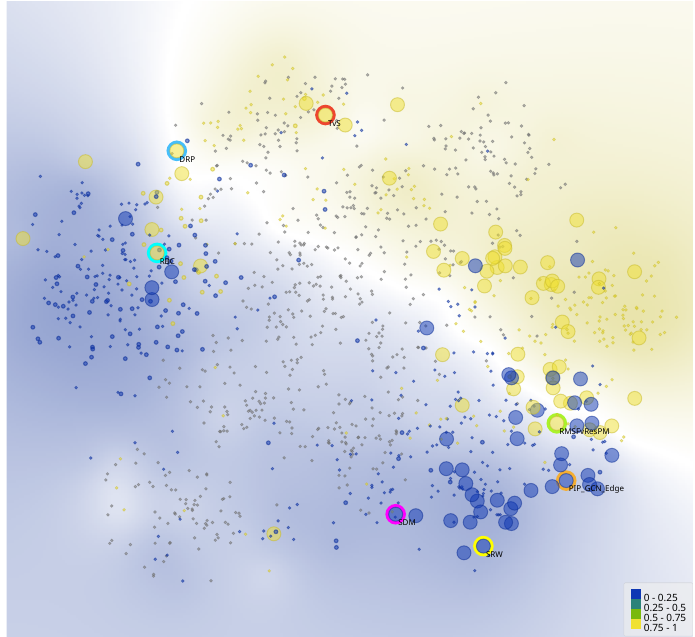
Figure 8. An example of feature clustering analysis with t-distributed stochastic neighbor embedding (t-SNE) where point color describes dynamic representability (yellow indicates that the feature describes dynamics), point size describes the ability to represent molecular complexes (large points indicate complexation is represented), and selected features are labeled by technique name. Seven unique features were selected, shown by a thick colored outline. From the top moving clockwise, TvS is temperature versus structural state [43]; RMSFvResPM is the root-mean-square fluctuation versus the residue pairwise matrix [44]; PIP_GCN_Edge is an edge feature vector for protein interface prediction [45]; SRW is a spectral random walk [46]; SDM is simulated electron density [47]; RBC is the rotatable bond count [48]; and DRP is a double reciprocal plot [49]. Similarity is indicated by the Euclidean distance between features. Figure generated in